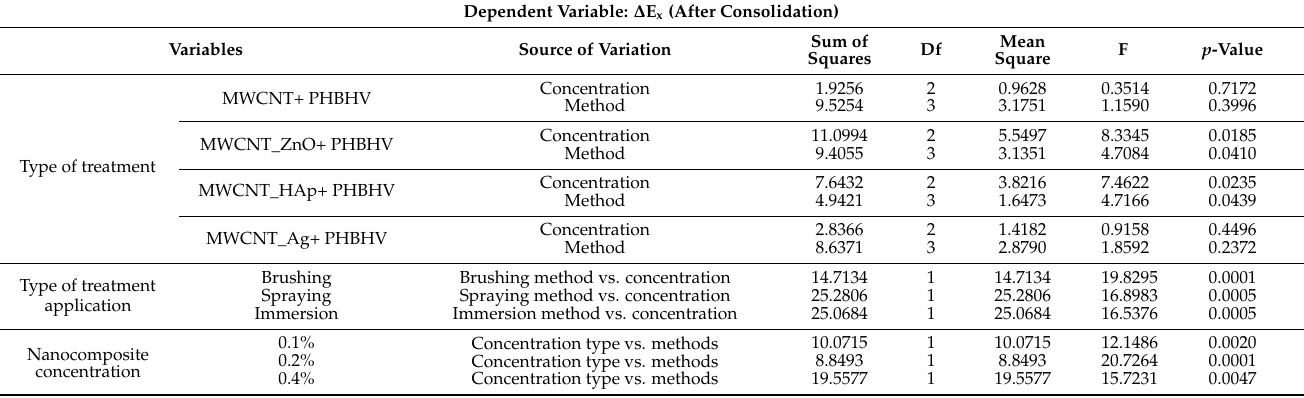
Table 3. ANOVA, color change with consolidation.